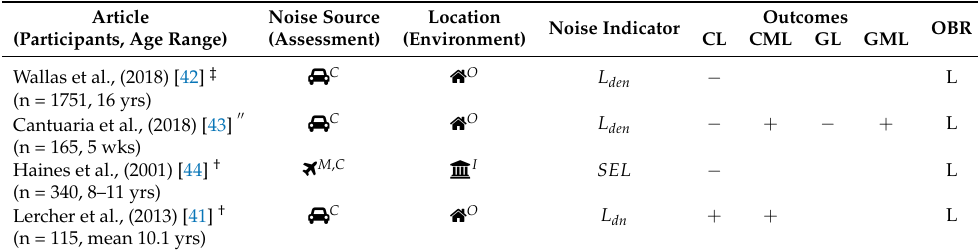
Table 6. Neuroendocrine-based studies. CL and CML refer to cortisol and its metabolite levels as well as GL and GML to glucocorticoid and its metabolite levels. For an explanation of symbols and notations, see the caption of Table 5.